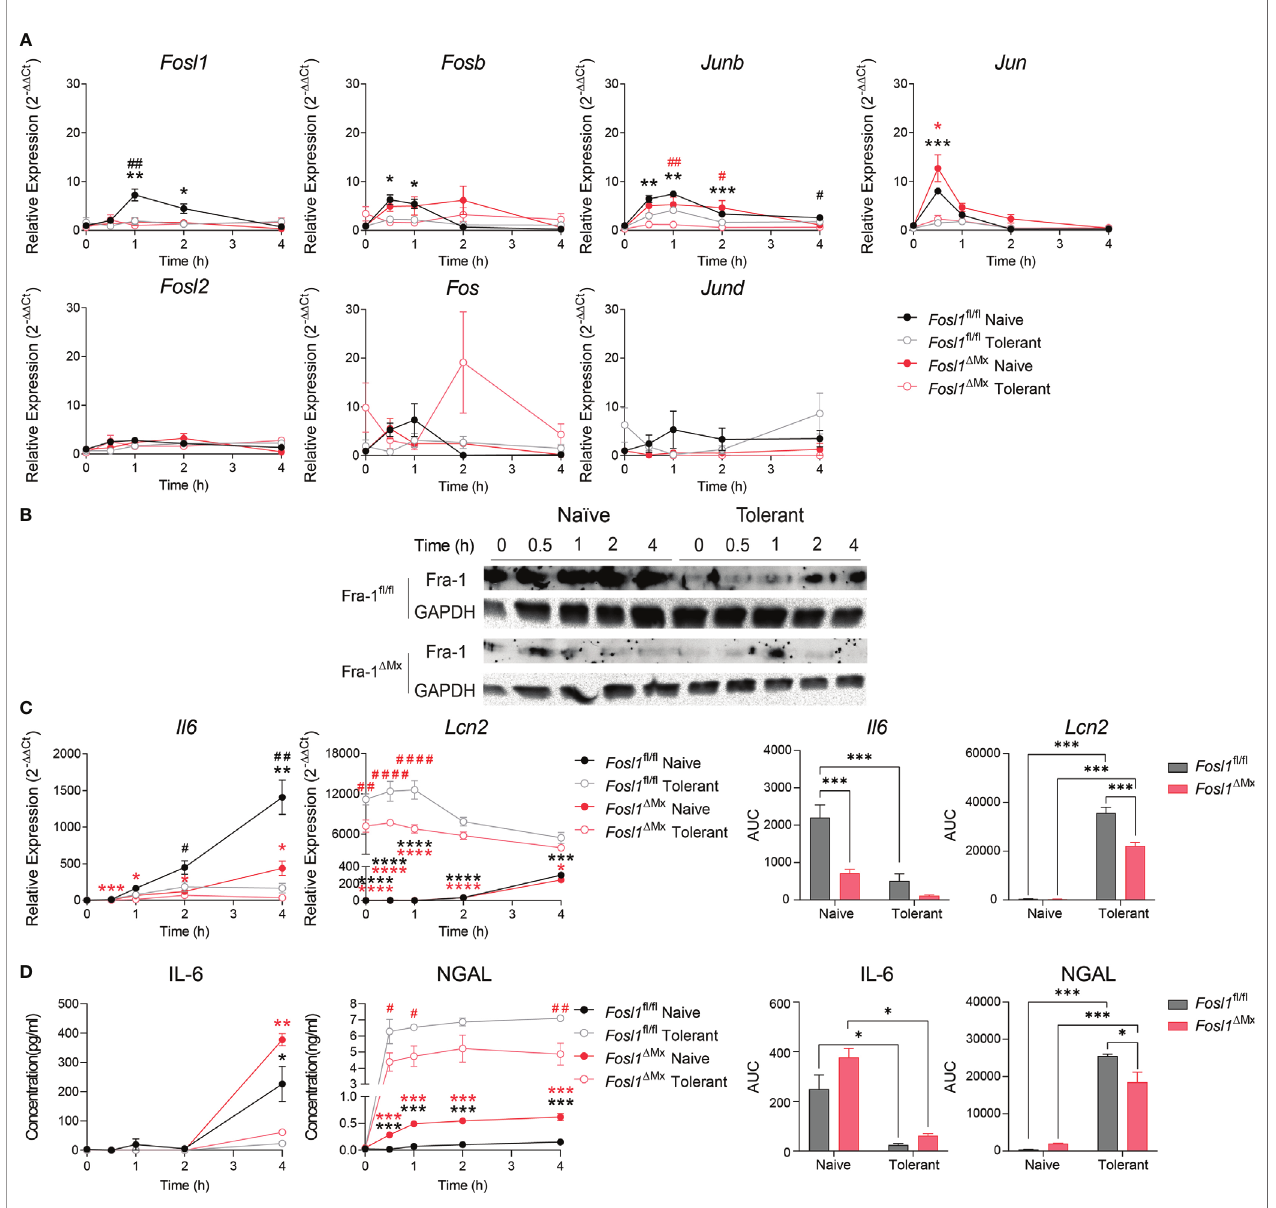
FIGURE 3 | Increased expression of Lcn2 after induction of endotoxin tolerance is reduced in Fosl1 knockout murine macrophages. (A) Quantitative RT-PCR analysis of AP-1 transcription factor gene expression in littermate control and Fra-1 de fi cient BMDM after LPS stimulation in both naïve and tolerant state, normalized to the expression of Actb . (B) Western blot detection of FRA-1 protein after LPS stimulation in littermate control and FRA-1 de fi cient BMDM in both naïve and tolerant state. GAPDH was used as loading control. (C) Quantitative RT-PCR analysis of Il6 and Lcn2 in littermate control and FRA-1 de fi cient BMDM after LPS stimulation in both naïve and tolerant state. Left panels represent the kinetic of gene expression normalized to the expression of Actb and right panels represent the area under curve (AUC) for the respective genes. (D) IL-6 and NGAL protein levels in the supernatant of wild type and FRA-1 de fi cient BMDM after LPS stimulation in both naïve and tolerant state. Left panels represent the kinetic of protein secretion and right panels represent the area under curve (AUC) for the respective protein. The data shown are from one experiment representative of three independent biological replicates and they are shown as mean ± s.e.m. *p < 0.05; **p < 0.01; ***p < 0.001; ****p < 0.0001 by two-way RM ANOVA with Tukey ’ s multiple comparisons test. Black asterisks indicated signi fi cant difference between naïve (n=6) versus tolerant (n=9) state in littermate control mice; red asterisk indicated signi fi cant difference between naïve (n=3) versus tolerant (n=9) state in FRA-1 de fi cient mice; # p < 0.05; ## p < 0.01; #### p < 0.0001 by two-way RM ANOVA with Tukey ’ s multiple comparisons test. Black hash sign indicated signi fi cant difference between FRA-1 de fi cient and littermate cells in naïve state; red hash sign indicated signi fi cant difference between FRA-1 de fi cient and littermate cells in tolerant